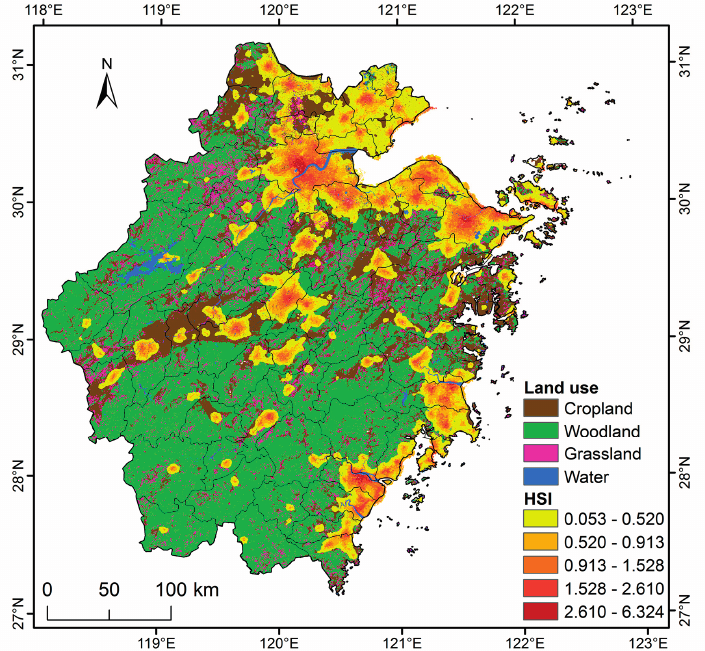
Figure 3. The fusion of Human Settlement Index and GlobCover 2009 land cover data for Zhejiang